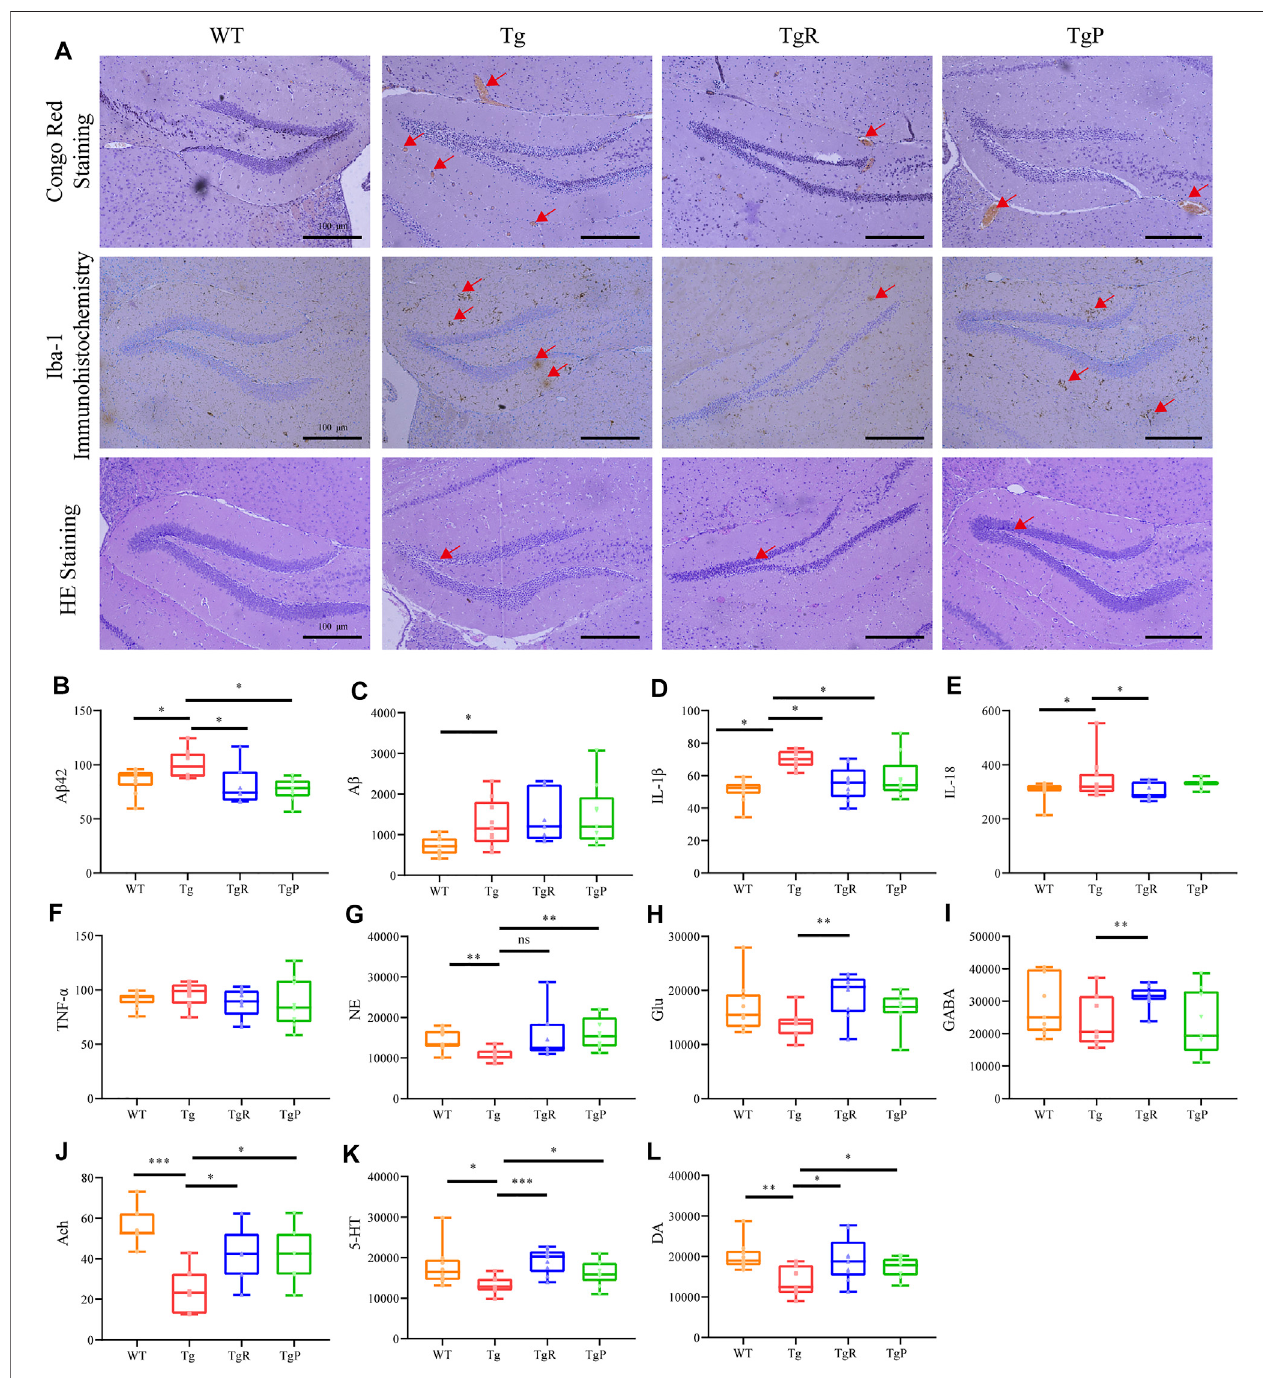
FIGURE 3 | Rhubarb alleviates the pathological changes in APP/PS1 mice. (A) Histopathology examination of the hippocampus in the brain. (Scale bar: 100 μ m). (B – L) Levels of β -amyloids, pro-in fl ammatory cytokines, and neurotransmitters in the brain. A β 42 (B), A β (C) , IL-1 β (D) , IL-18 (E) , TNF- α (F) , norepinephrine (NE) (G) , glutamate (Glu) (H) , γ -aminobutyric acid (GABA) (I) , Acetylcholine (Ach) (J) , serotonin (5-HT) (K) , dopamine (DA) (L) . Values are expressed as the mean ± S.E.M.; n (cid:1) 9; * p < 0.05 versus Tg; ** p < 0.01 versus Tg; ** p < 0.001 versus Tg, by Student ’ s unpaired t -test.